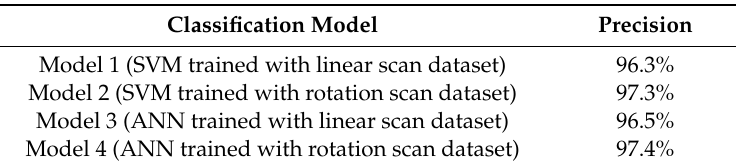
Table 1. Classification results of support vector machine (SVM) and artificial neural network (ANN) models with the use of data set obtained by linear and rotation scan.